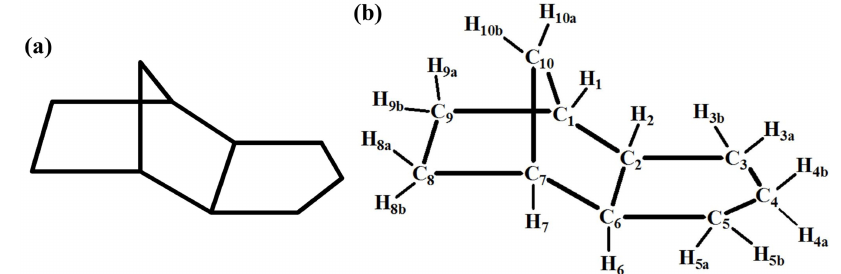
Figure 4. Molecular configuration of JP-10 [46]: ( a ) in the form of hydrocarbon skeleton; ( b ) with hydrogen and carbon atoms with